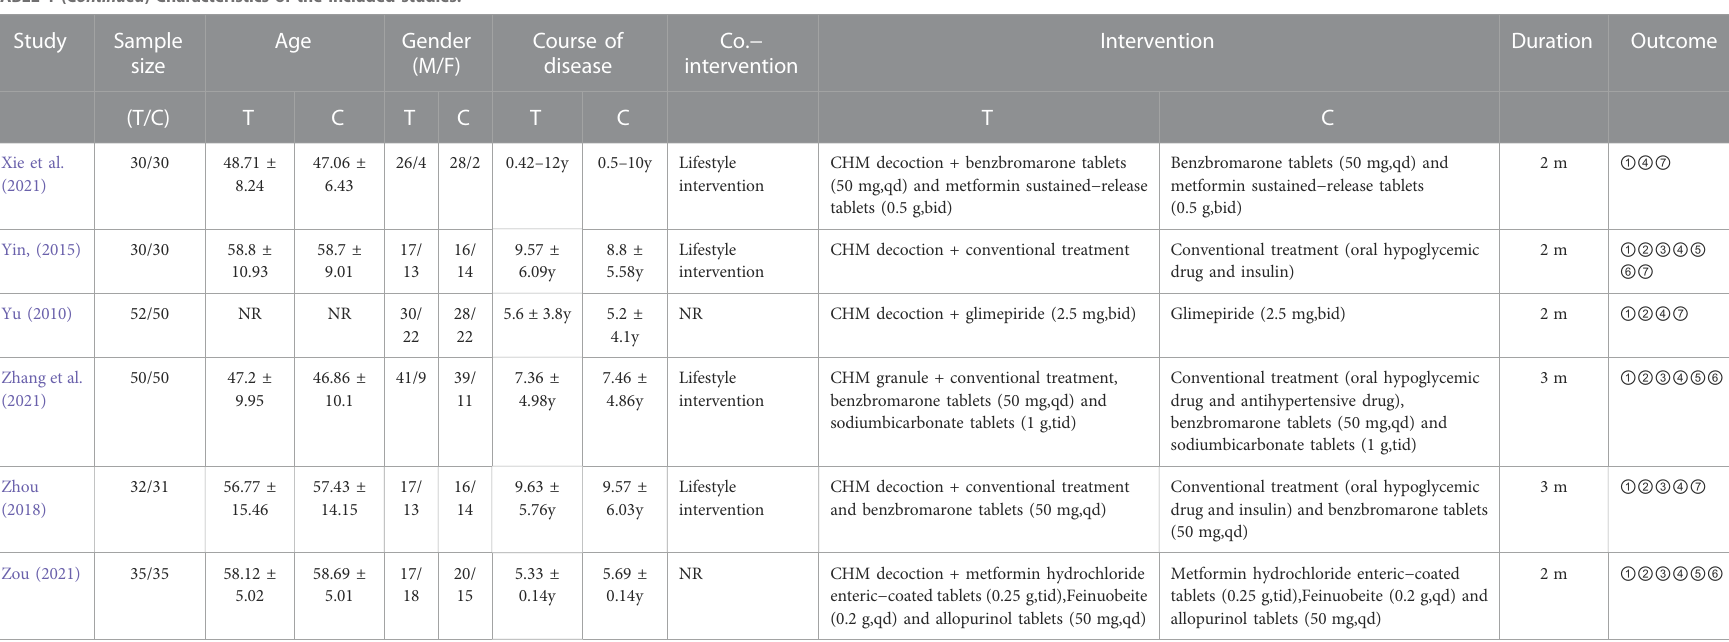
TABLE 1 ( Continued ) Characteristics of the included